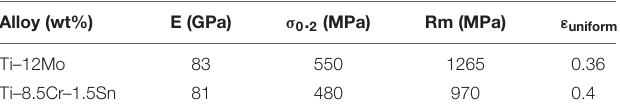
Alloy (wt%) σ 0 . 2 (MPa)